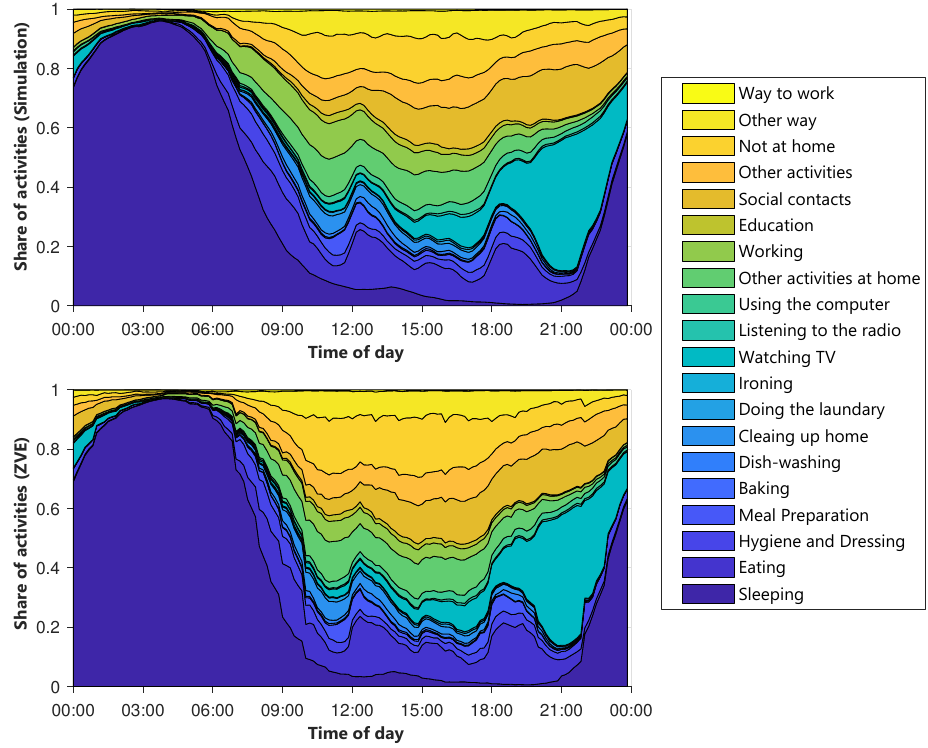
Figure A3. Average layered course of the activities for Saturday.